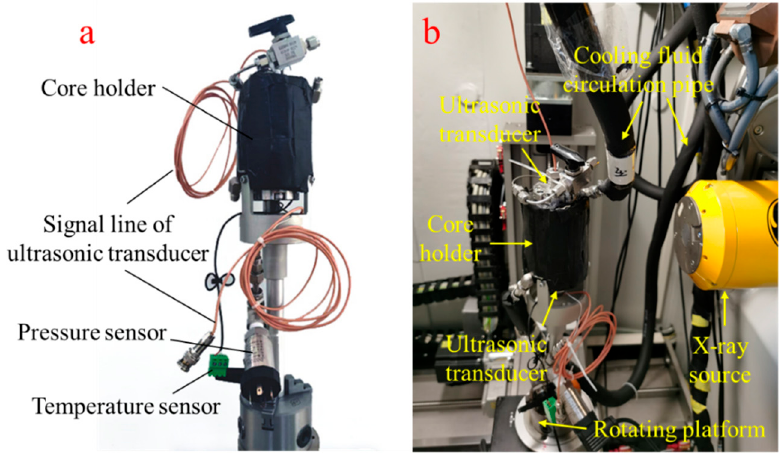
Figure 3. Actual display of ( a ) the core holder and ( b ) the X-CT scanning system. It should be noted that the pressure-bearing cylinder included an inner pressure- bearing cylinder and an outer pressure-bearing cylinder. The ultrasonic transducers were arranged at the upper and lower ends of the inner pressure-bearing cylinder. The inner cylinder was fixed and pressed against the sealing end cover, and the space between the sealing end cover and the ultrasonic transducer was sealed by the pressure block